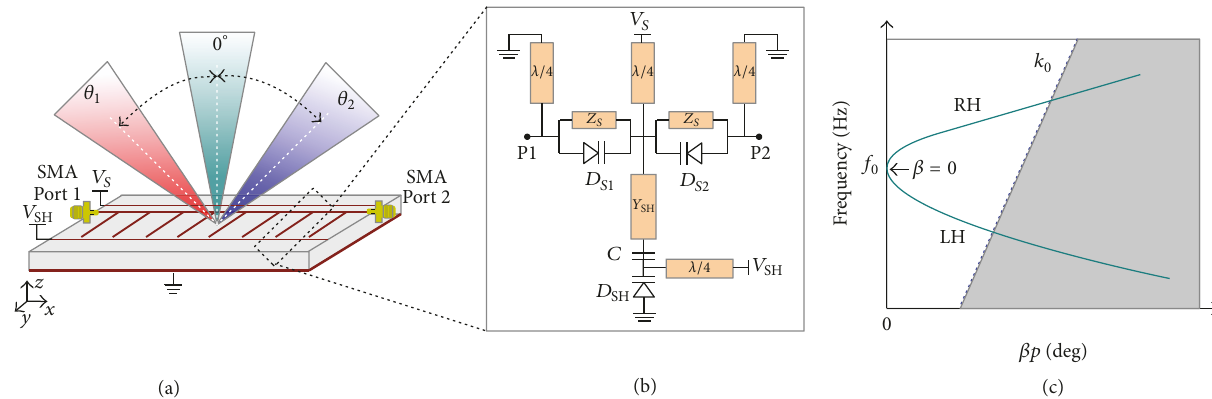
Figure 1: (a) Sketch of a CRLH Leaky-Wave Antenna with beam steering from broadside 𝜃 = 0 ∘ to backward 𝜃 1 and forward 𝜃 2 angles. (b) Schematic of a conventional CRLH unit cell. (c) Dispersion diagram used to evaluate the propagation constant 𝛽 and estimate the main beam angle 𝜃